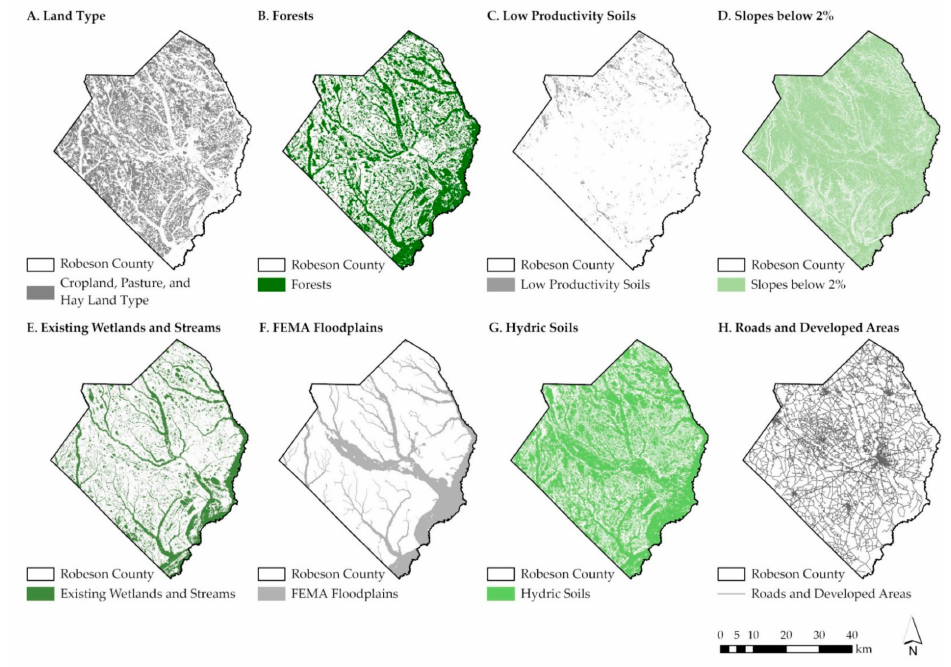
Figure 10. Results of Robeson County inventory mapping including: cropland, pasture, and hay ( A ); forests ( B ); low-productivity soils ( C ); slopes below 2% ( D ); existing wetlands and streams ( E ); FEMA floodplains ( F ); hydric soils ( G ); and roads and developed areas ( H